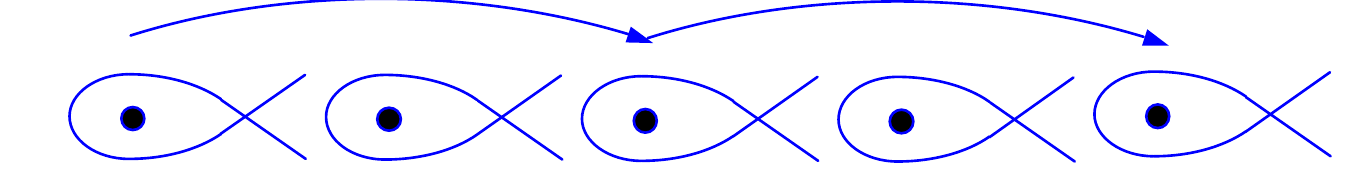
FIG. 2. (Color) rf bucket jump at cavity crossings by (cid:1) h rf wavelengths (harmonic